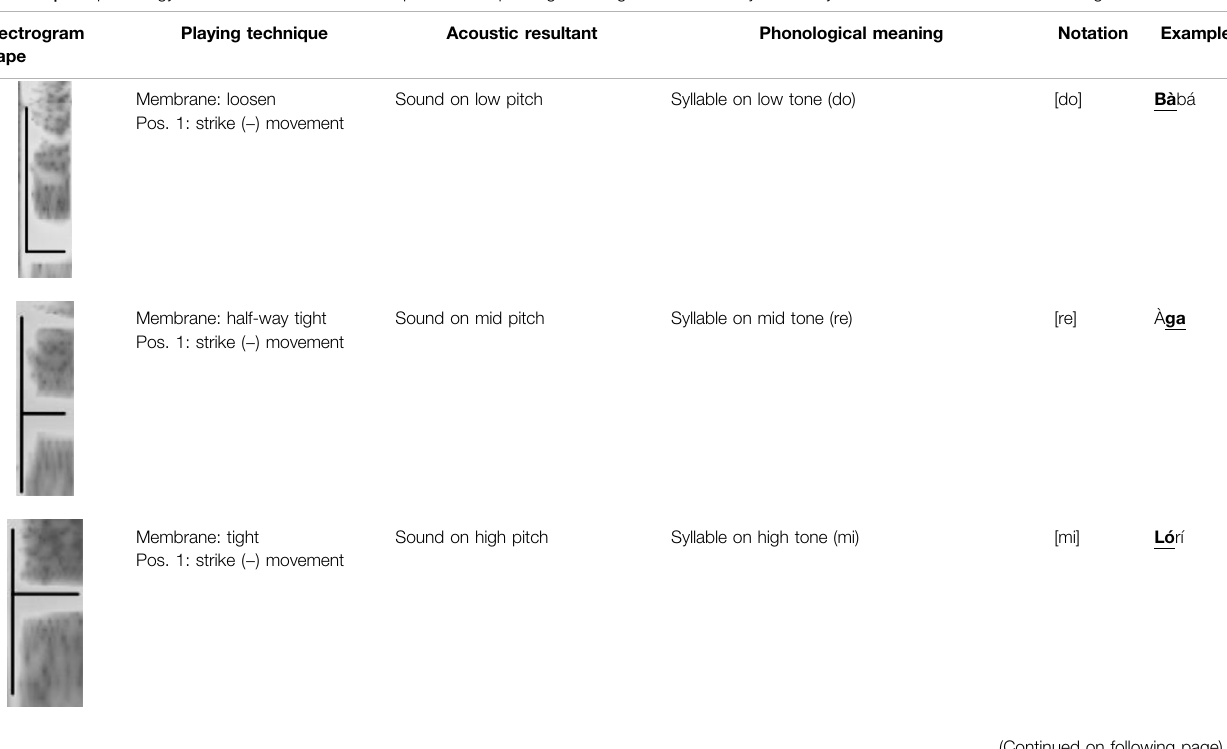
TABLE 1 | The phonology of the dùndún . The black shapes on the spectrogram images were manually added by the researchers to facilitate reading. Spectrogram shape